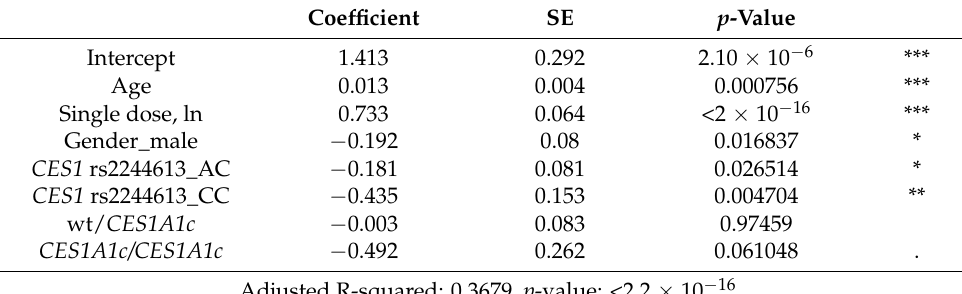
Table 3. Linear regression analysis on peak enalaprilat concentration.